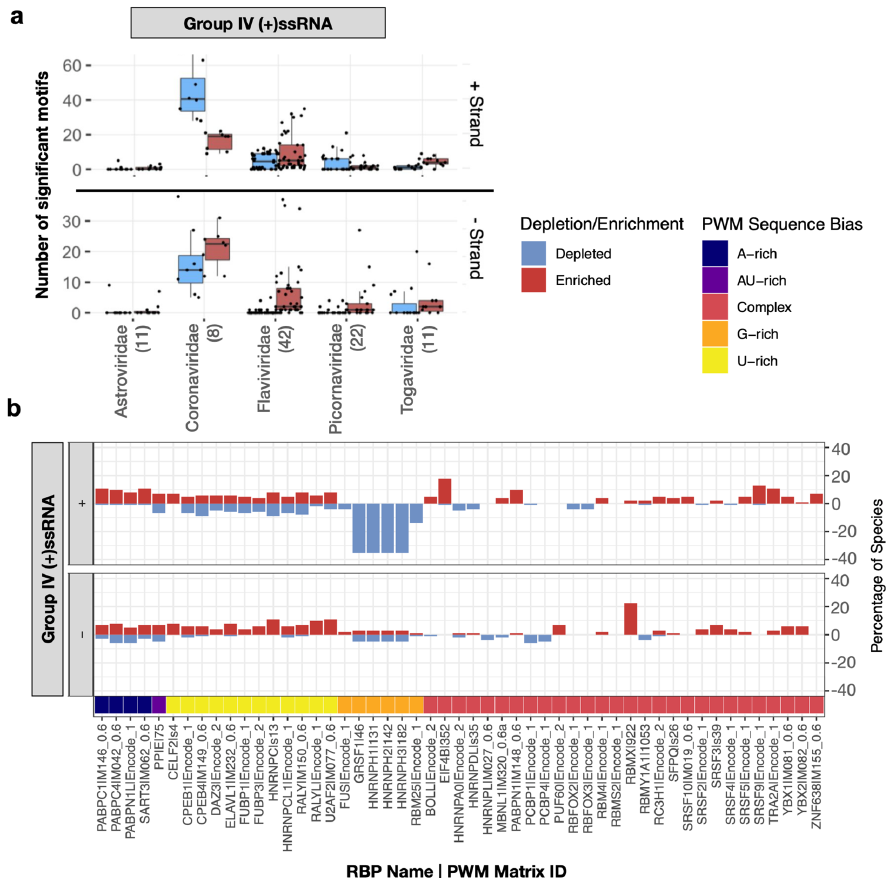
Figure 2. SMEAGOL uncovers RBPs whose binding motifs are enriched or depleted in ssRNA virus genomes. ( a ) Number of motifs significantly enriched or depleted in each family of Group IV viruses. The number of genomes per family is given in parentheses. Families with more than five genomes in our dataset were included. Box plots are defined as follows: centre line, median; box limits, upper and lower quartiles; whiskers, 1.5× interquartile range. Individual data points are also shown. ( b ) Percentage of viral genomes with significant (two-sided binomial test, FDR-adjusted p -values < 0.05) enrichment (in red) and depletion (in blue) per PWM, separated by viral genome strand. For readability, shown are only representative PWMs that had more than three significant enrichment/depletion events. The PWM sequence bias (see Methods) is presented on the bottom of the plot. While some PWMs have a more complex sequence (light red), others are rich in single nucleotides (A-rich in navy blue, AU-rich in purple, U-rich in yellow, and G-rich in orange). The results for Group V viruses can be found in Supplementary Figure S5 and a comprehensive figure that contains all representative PWMs is provided as Supplementary Figure S6.